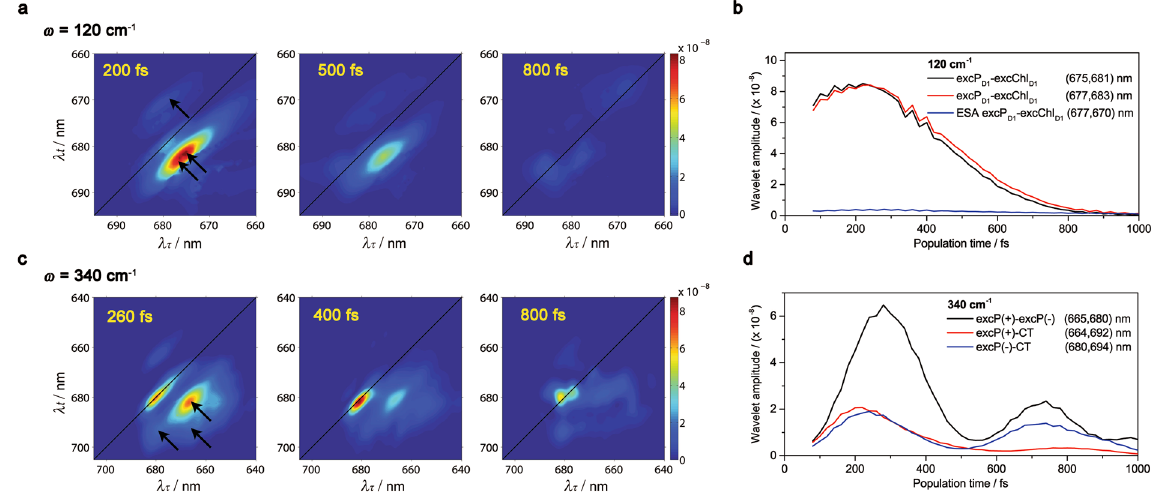
Figure 2. Dynamics of vibronic coherence in the PSII RC at 80 K: time-resolved 2D frequency maps ( a , c ) and wavelet traces ( b , d ). ( a ) 120 cm − 1 time-resolved 2D frequency maps at T = 200, 500 and 800 fs. The black arrows in the 200 fs time-resolved 2D frequency map indicate the position of the selected 2D traces. ( b ) 120 cm − 1 2D wavelet traces. ( c ) 340 cm − 1 time-resolved 2D frequency maps at T = 260, 400 and 800 fs. The black arrows in the 260 fs time-resolved 2D frequency map indicate the position of the selected 2D wavelet traces. ( d ) 340 cm − 1 2D wavelet traces.